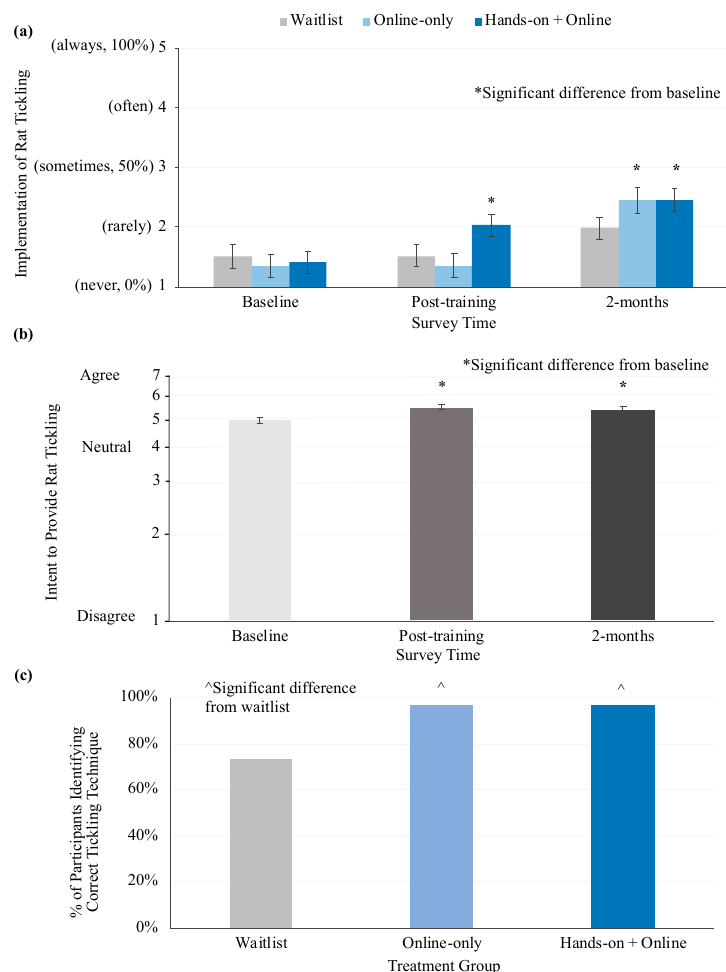
Figure 3. Implementation and intent to provide rat tickling / correct identification of technique. ( a ) and ( b ) This figure shows the highest order significant associations from general linear mixed models that impacted participants current implementation and intent to provide rat tickling. Implementation and intent were measured via a self-report survey. Models were run controlling for potential confounding variables. Both scales display only the range of possible responses. Data is presented as least squares mean ± standard error of the mean. The scale of intent is back transformed from log10. (a) * indicates a significant di ff erence from baseline within treatment group. (b) * indicates a significant di ff erence from baseline. ( c ) The bottom graph shows the percentage of participants that selected a dorsal contact + pin picture when asked to identify which picture indicates the correct rat tickling technique. ˆ indicates a significant di ff erence from